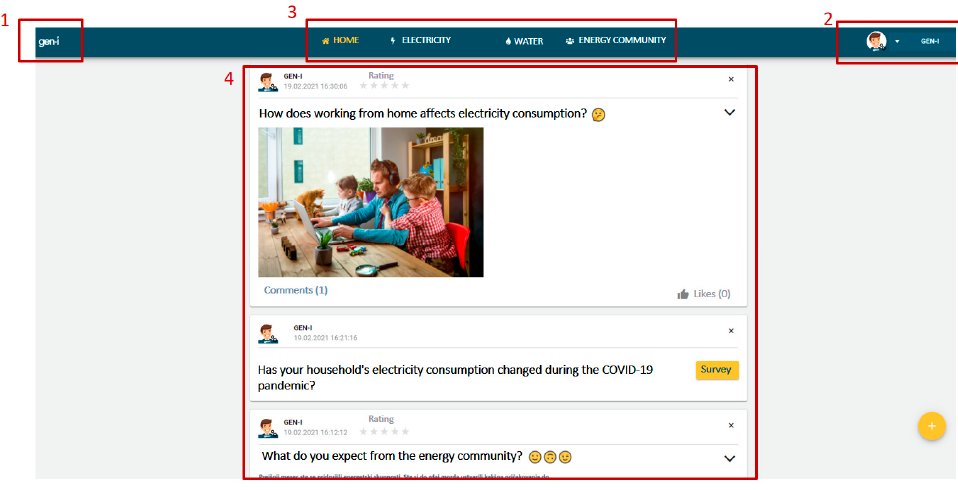
Figure 6. Home tab of the portal.